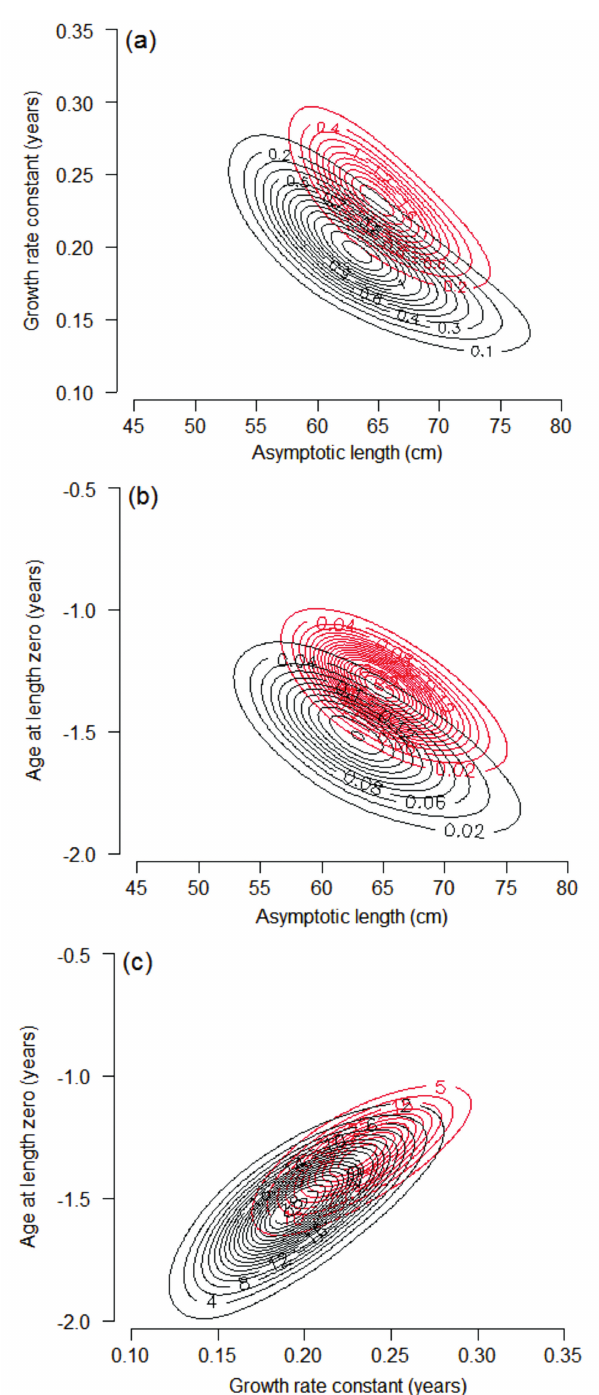
Fig. 7. Relationship between Piaractus mesopotamicus growth parameters: a. growth rate constant and asymptotic length b. age at length zero and asymptotic length and c. age at length zero and constant growth rate for males (black) and females